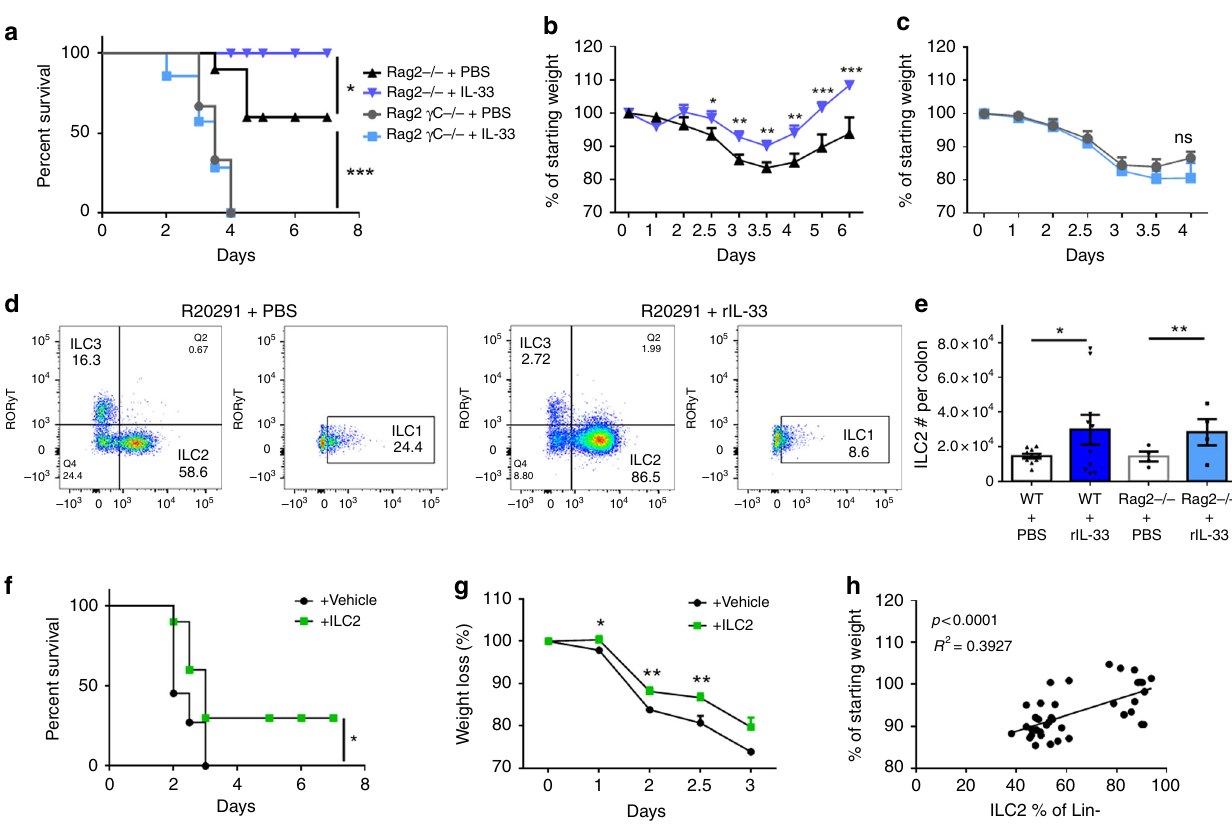
Fig. 4 IL-33-ILC2 crosstalk is protective during C. dif fi cile infection. a – c Rag2 − / − and Rag2 − / − γ c − / − were infected with R20291 and treated with or without IL-33. a Survival curves, ( b ) Rag2 − / − weight loss, and ( c ) Rag2 − / − γ c − / − weight loss after IL-33 treatment and infection. d , e Immune cell pro fi ling of ILCs within the colon of IL-33-treated or untreated mice during R20291 infection. ILCs were subsetted into ILC2s (Lin- CD45 + CD90 + CD127 + GATA + ST2 + ); ILC1s (Lin- CD45 + CD90 + CD127 + Tbet + ), and ILC3s (Lin- CD45 + CD90 + CD127 + RORyT + ) by fl ow cytometry. d Representative dot plots of ILC subsets within the colon of PBS controls or IL-33-treated mice during infection (day 2). e Enumeration of the number of ILC2s in the colon of IL-33-treated C57BL6 or Rag2 − / − mice during R20291 infection. f, g Adoptive transfer of ex vivo expanded and sorted puri fi ed ILC2s from uninfected IL-33 treated mice into naive Rag2 − / − γ c − / − mice. f Survival curves and ( g ) weight loss after ILC2 transfer and R20291 infection. h Pearson correlation between the frequency of ILC2s and the percent weight loss during R20291 infection. a, f Comparison made by log rank test ( a , n = 6, 7, 10, 10; f , n = 11, 10). ( b , c , e , g ) Comparison made by two-tailed Student's t test ( b , n = 8; c , n = 17,15; e , n = 10, 10, 4, 4; g , n = 10). h Comparison made by Spearman correlation ( h , n = 39 ) . a – c The data representative of two independent experiments. d – h The data representative of three independent experiments. Statistical signi fi cance is demarked as * P < 0.05, ** P < 0.01, and *** P < 0.001. Error bar indicates